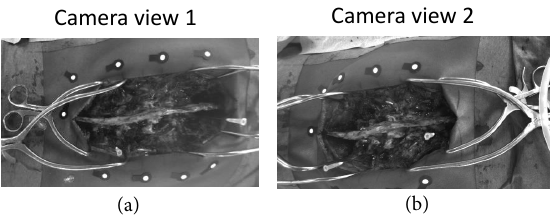
Figure 7. A pair of frames, captured by the camera view 1 ( a ) and the camera view 2 ( b ) for a unit of time, is visualized.